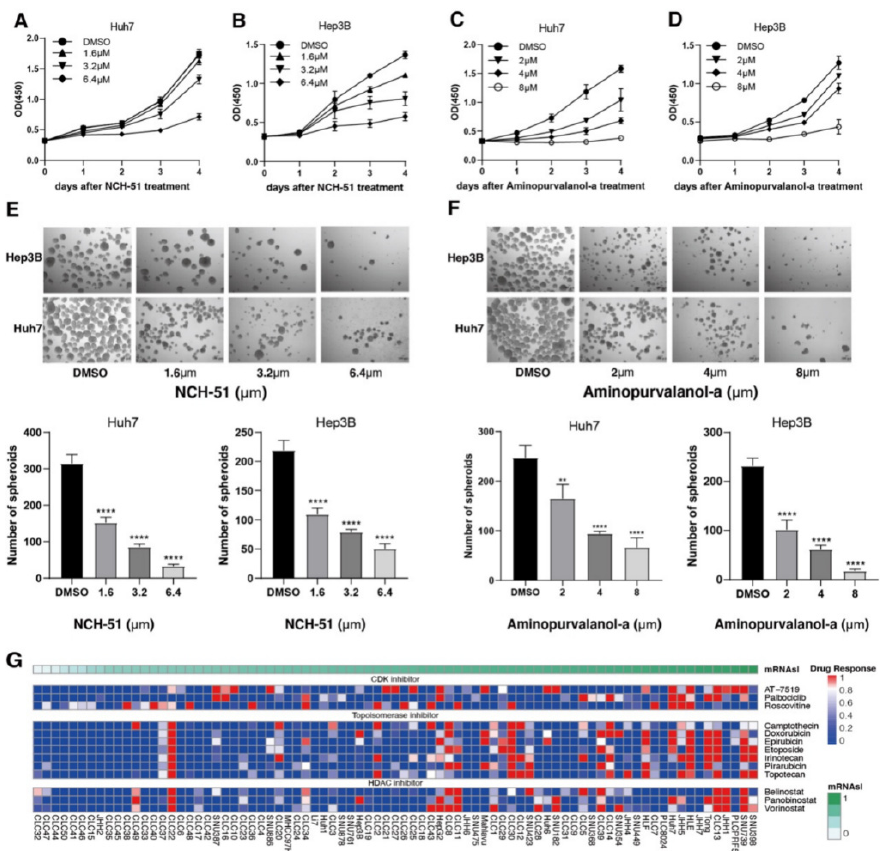
Figure 8 . Assessment of the response to potential compounds by in vitro experiment and the LIMORE data set. ( A – D ) Results of the CCK8 assay: both Aminopurvalanol-a and NCH-51 effectively suppressed proliferation and viability of Huh7 and Hep3B cells. ( E , F ) Results of the. sphere formation assay: sphere forming-ability of Huh7 and Hep3B cells was suppressed by Aminopurvalanol-a and NCH-51 (**, p < 0.01; **** p < 0.0001). ( G ) Heatmap exhibiting inhibitors of topoisomerase, CDK, and HDAC with drug response in 81 liver cancer cell lines.